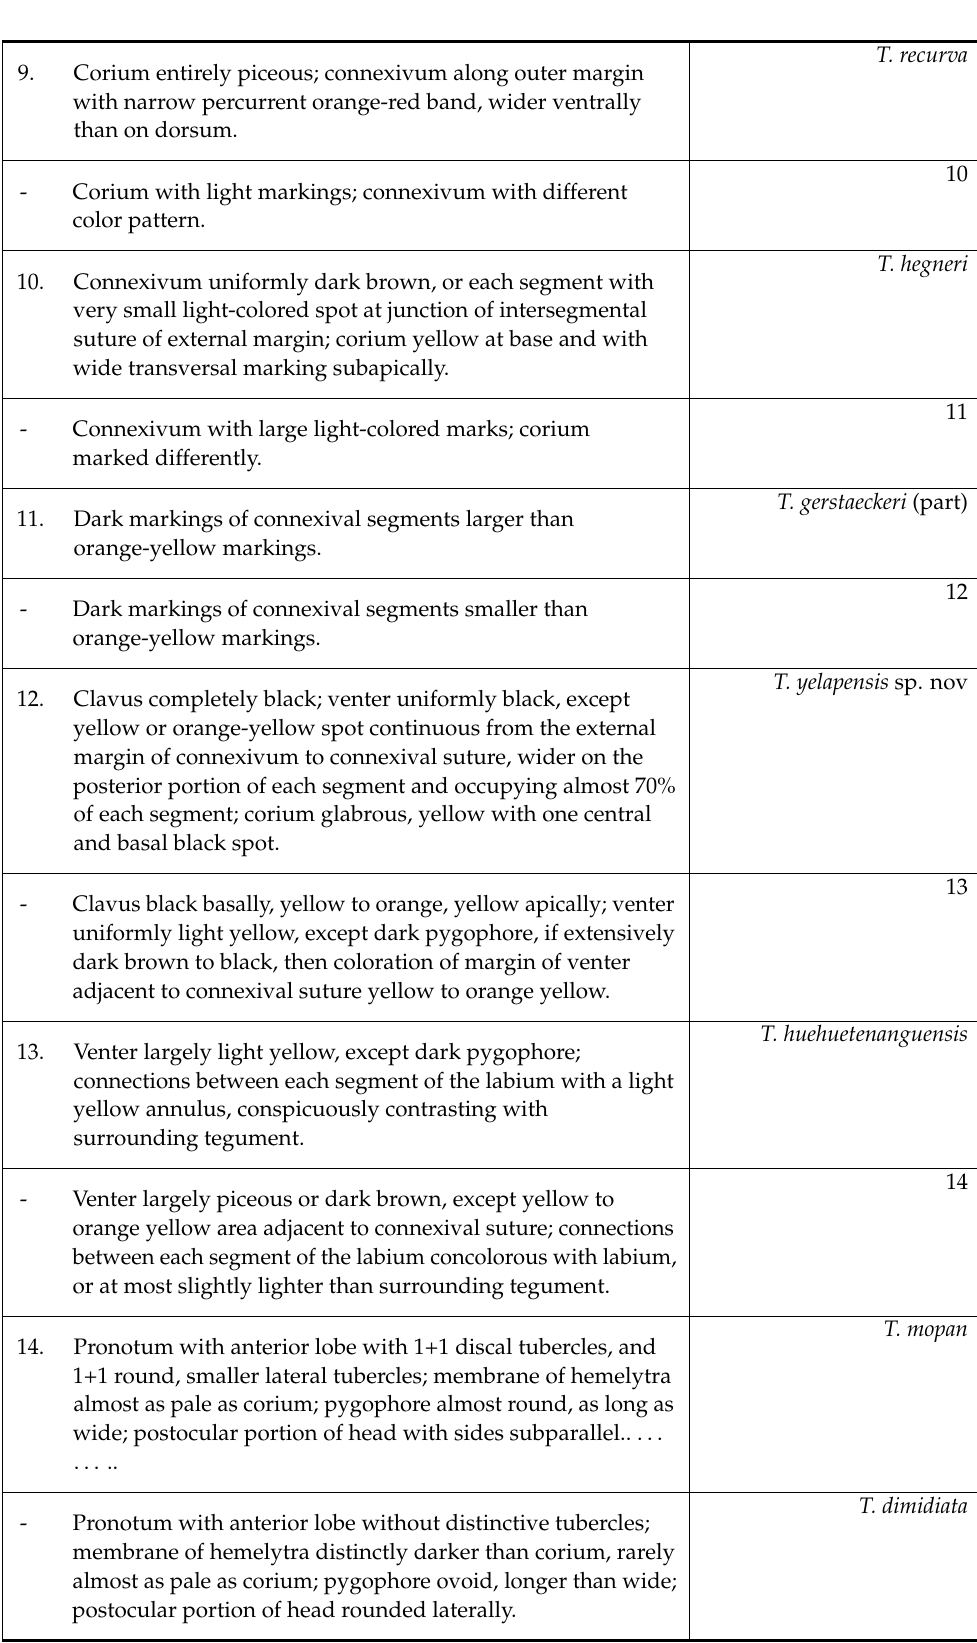
Pronotum with anterior lobe without distinctive tubercles; membrane of hemelytra distinctly darker than corium, rarely almost as pale as corium; pygophore ovoid, longer than wide; postocular portion of head rounded